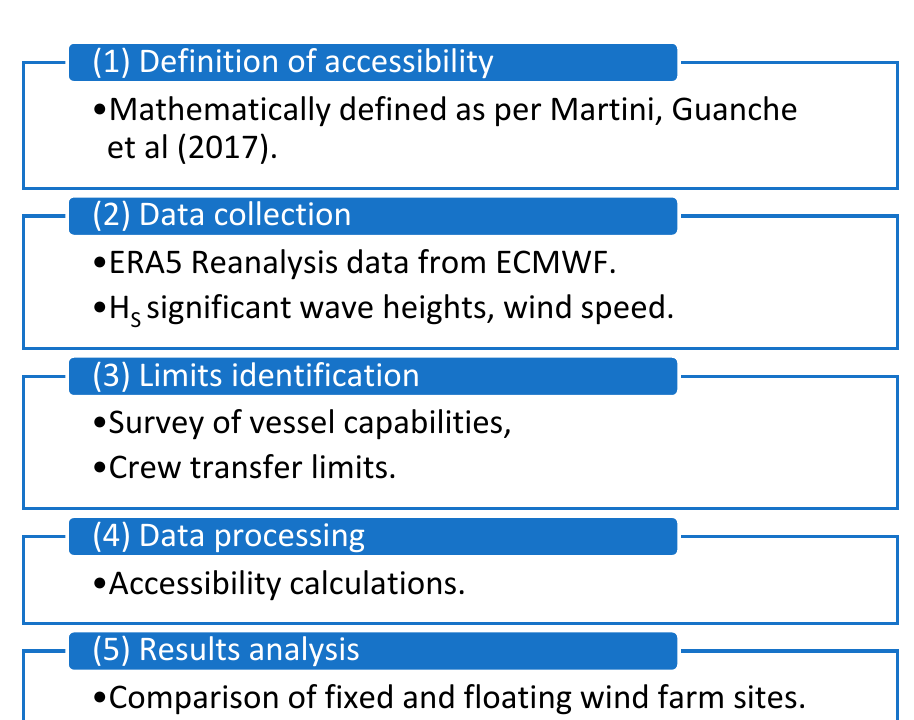
Figure 1. Weather window example.